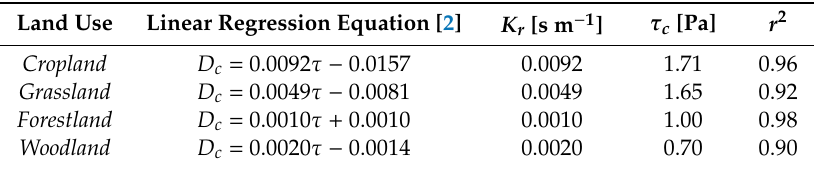
Figure 6. Linear regression equations between rill detachment capacity and shear stress to estimate rill detachment and critical shear stress in cropland ( a ), grassland ( b ), forestland ( c ) and woodland ( d ) in the Saravan watershed (Iran) ( n = 25). Table 7. Results of regression analysis between the rill detachment capacity ( D c ) and shear stress ( τ ) in four land uses of the Saravan watershed (Northern Iran) ( n = 25).